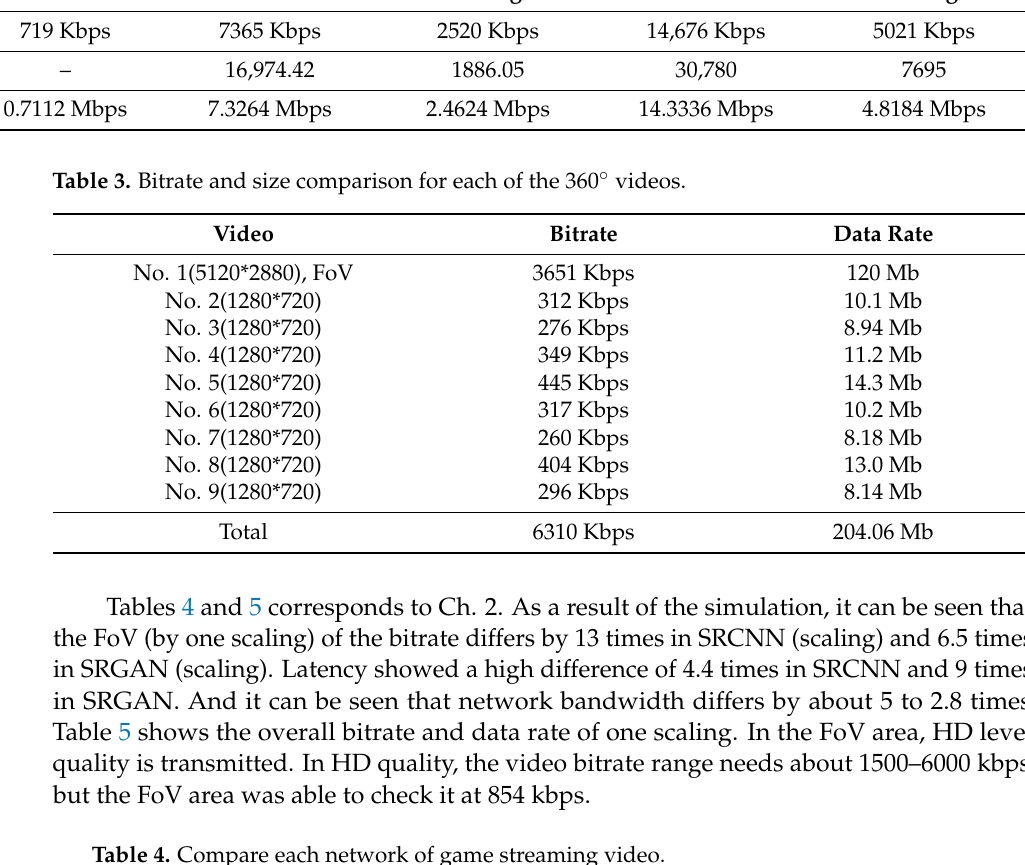
Table 4. Compare each network of game streaming